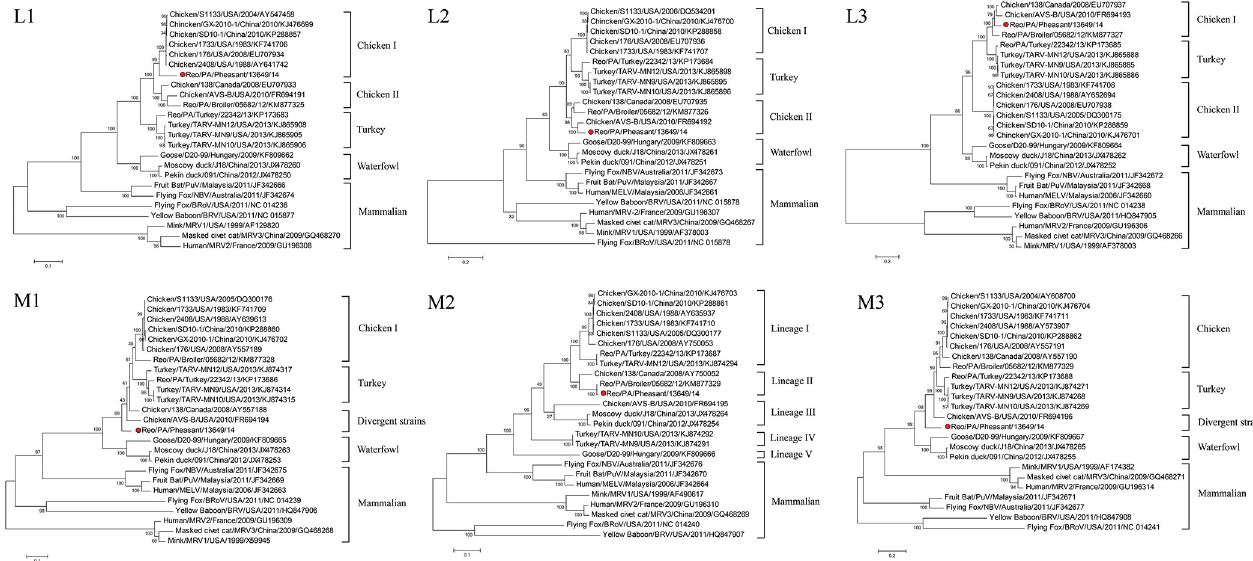
Fig 3. Phylogenetic trees constructed by avian orthoreovirus (ARV) based on nucleotide sequences of the L-class, M-class and σ -class homologous genome segments or genes. Note: The Reo/SDWF /Pheasant/17608/20 strain was marked with a red color dot.